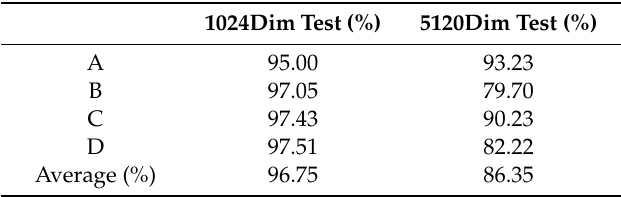
Table 4. Comparison of the accuracy of di ff erent length signals based on convolutional neural networks